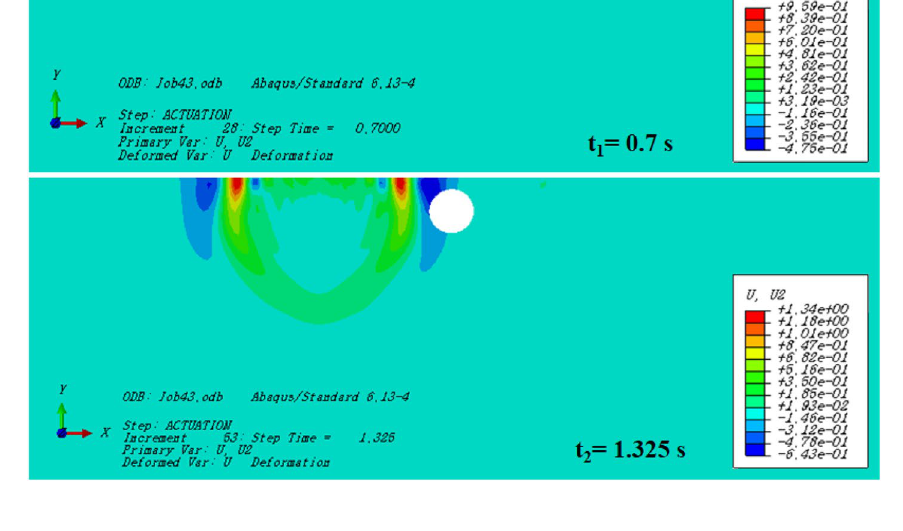
Fig. 4 The numerical model of a soil-cavity system in